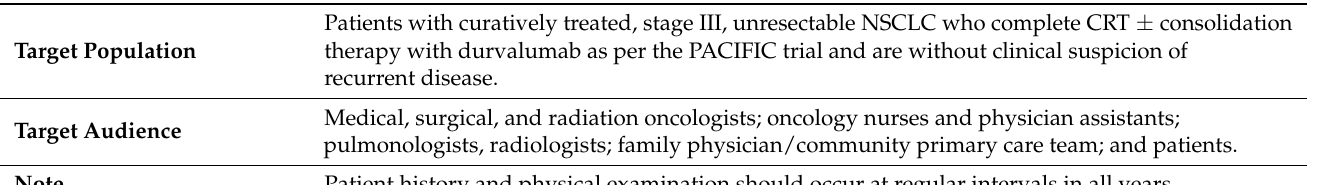
Table 1. Summary of clinical questions, recommendations, and key considerations.